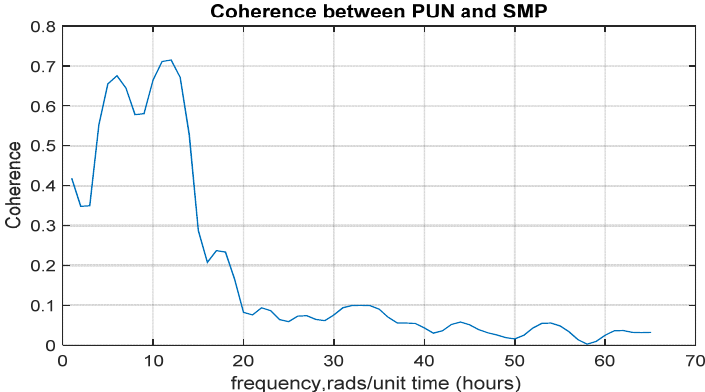
Figure 18. Coherence plot between the SMP and PUN hourly